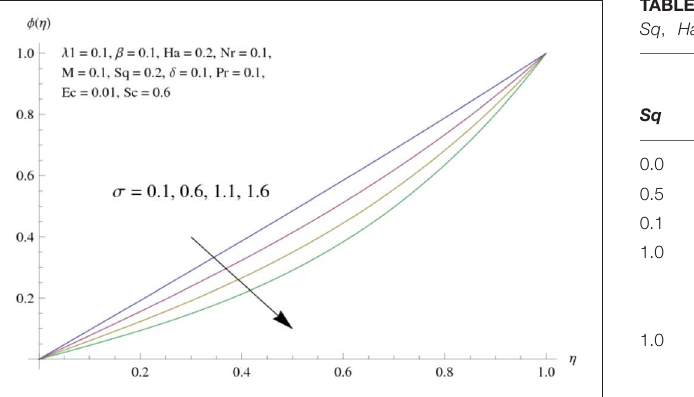
FIGURE 12 | Behavior of σ on φ ( η ).